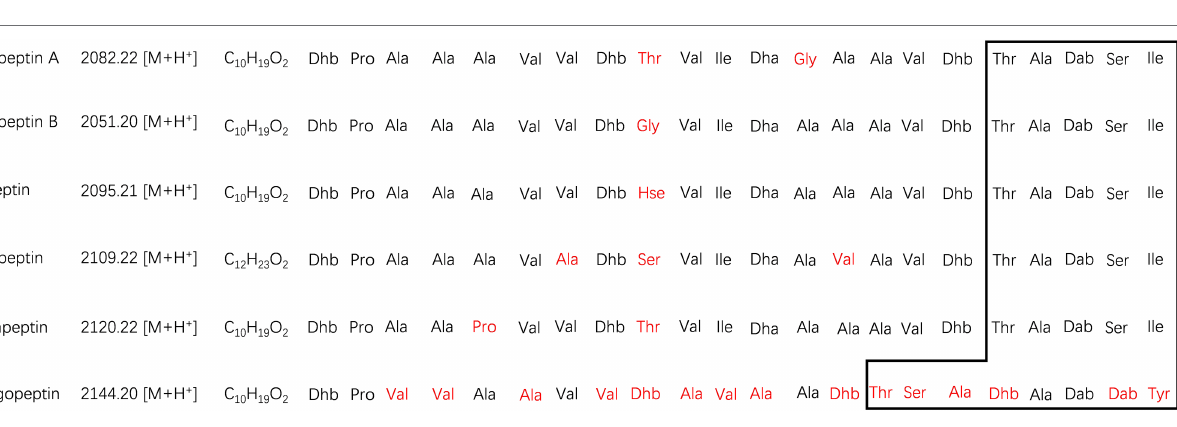
FIGURE 2 | Comparison of medipeptins with similar CLPs. The macrolactone ring shaped between the C-terminus of each peptide and a hydroxyl group of a threonine is remarked by square area. The different parts in medipeptins, compared with other CLPs, were marked in red. Non-canonical amino acids are abbreviated as follows: Dhb, dehydrobutyrine; Hse, homoserine; Dha, dehydroalanine; and Dab, 2,4-diaminobutyric